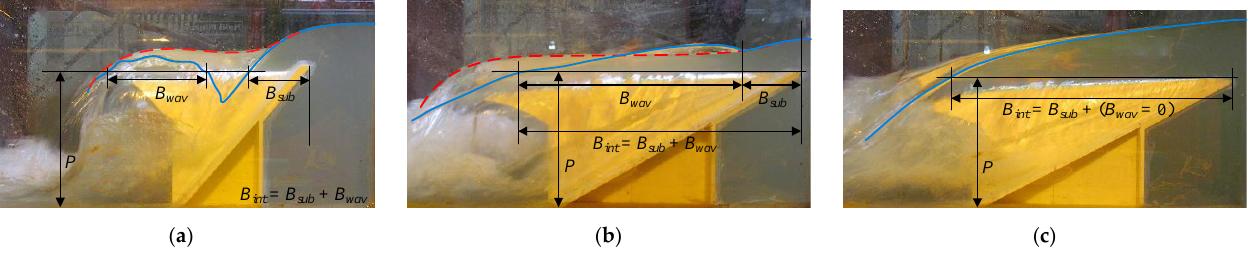
Figure 16. Nappe interference characteristics: ( a ) Rec-B1, H o / P = 0.30; ( b ) Tra-B2, H o / P = 0.30; ( c ) Tri-B2, H o / P = 0.49;( water surface profile in outlet key centerline; water surface profile in inlet key centerline).